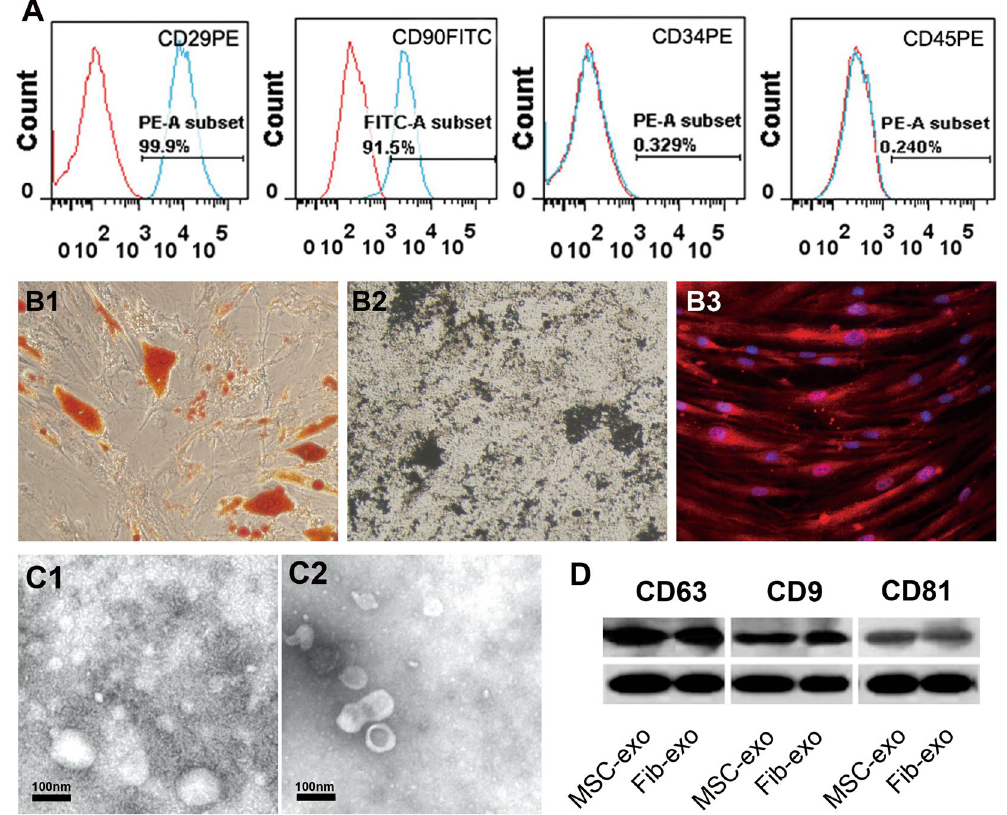
Figure 1. Identification of MSC and MSC-Exo. ( A ) Immunophenotypes of the cultured hMSCs were examined by flow cytometry. The vast majority of cells ( > 90%) were positive for CD29, CD90, but few cells ( < 0.5%) expressed CD34, CD45. ( B ) The hMSCs were maintained in specific induction media for 3 weeks, and the induced cells were then stained by oil red O to indicate adipocytes (B1), von Kossa for osteocytes (B2). For endothelial cell identification, the cells were firstly incubated with antibodies against vWF (B3), and then stained by secondary antibodies conjugated with Alexa Flour 647. ( C ) Micrographs of scanning electron microscopy of (C1) MSC-Exo and (C2) Fib-Exo show spheroid shaped vesicles at the diameter of about 40- 100 nm. Scale bar = 200 nm. ( D ) Western blot analysis showed that both MSC-Exo and Fib-Exo express CD63, CD9 and